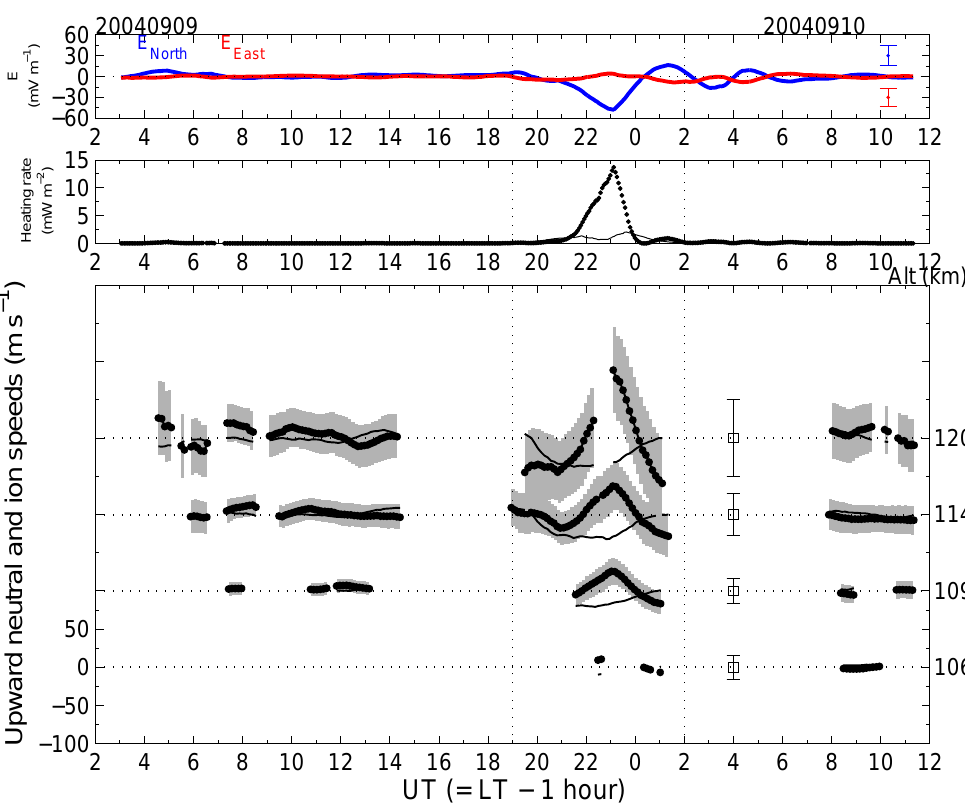
Fig. 1. Upper panel shows temporal variations in northward (blue) and eastward (red) components of the electric field measured with the EISCAT KST UHF radar from 03:00UT on 9 September to 11:00UT on 10 September 2004. Vertical bars at the right-hand-side are the mean error values from 19:00 to 02:00UT with ± 1 σ for each component. Middle panel shows the height-integrated passive-energy deposition rate, 6 p E 2 (dotted line), and the height-integrated particle heating rate (solid line) from 19:00 to 02:00UT. Bottom panel shows the upward neutral-wind speed (solid curve with dots) and the upward ion speed (solid curve) from 106 to 120km. The estimated error of vertical neutral-wind speed is shown by gray shading above and below the line. The vertical bar with a square at each height is the mean error value ± 1 σ of the vertical neutral-wind speed from 19:00 to 02:00UT. Horizontal dotted lines illustrate 0ms − 1 at each height. Vertical dotted lines in each panel are plotted at 19:00UT on 9 September and 02:00UT on 10 September 2004. All values are calculated using running-averaged data with 64-min boxcar window